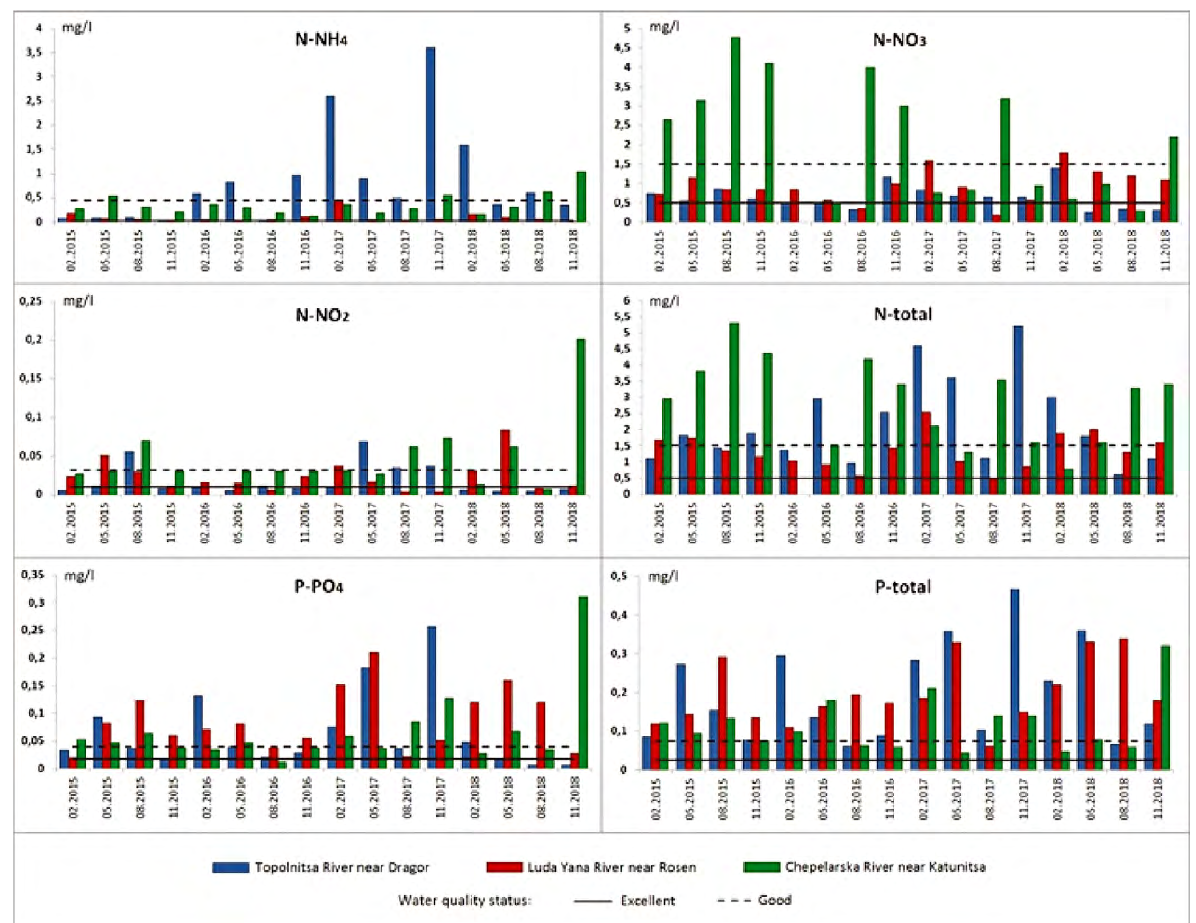
Figure 2. Dynamics in the concentration of nitrogen and phosphorus compounds compared to the maximum permissible limits pointed out in Regulation 4/2012 for characterization of the surface